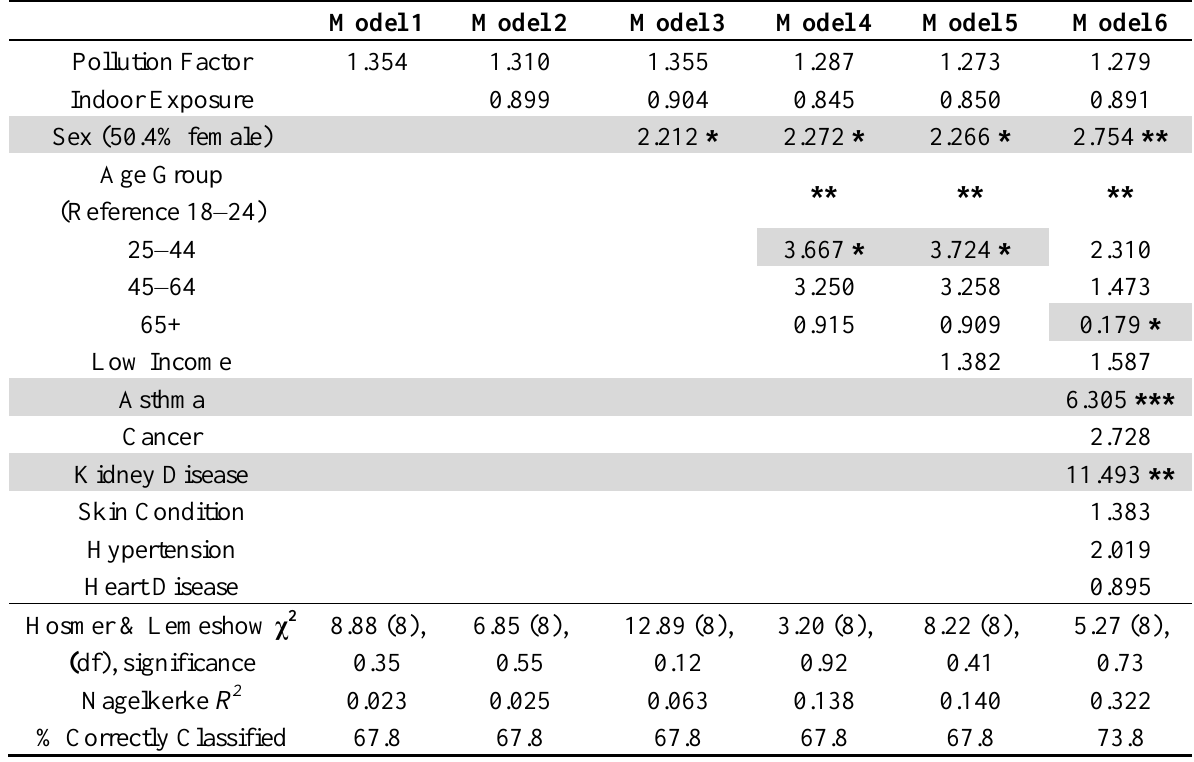
Table 6. Odds ratios for 5+ cardinal symptoms—allergies or hay fever (n =